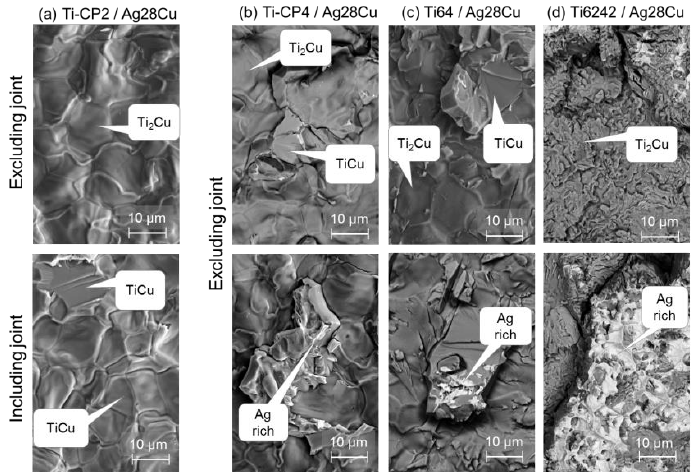
Figure 8. SEM+EDS investigation of the fracture surfaces of both halves of the Ti-CP2/Ag28Cu specimen, i.e., excluding the joint at the top and including the joint at the bottom ( a ), fracture surfaces of the parts excluding the joint for Ti-CP4/Ag28Cu ( b ), Ti64/Ag28Cu ( c ) and Ti6242/Ag28Cu ( d ). All indicated phases were identified by EDS at the pointed